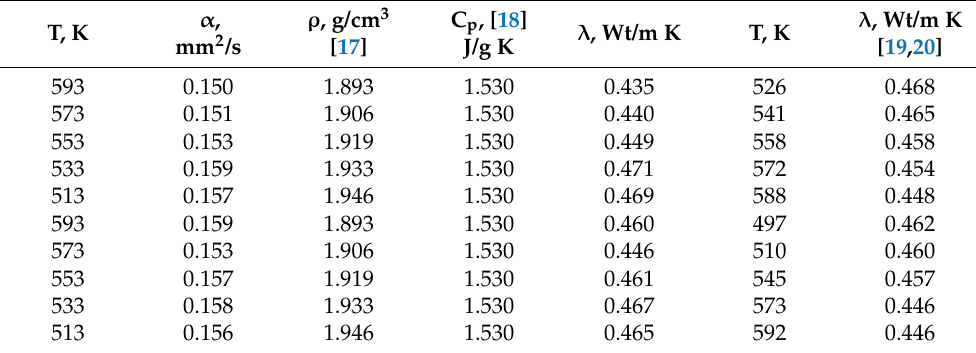
Table 1. Thermophysical data for NaNO 3 -KNO 3 eutectic mixture.